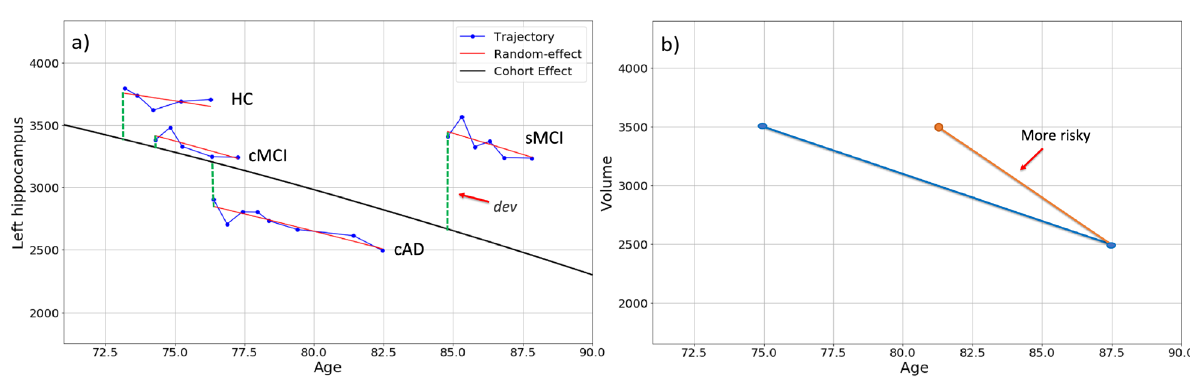
Figure 2. Box plot showing the gender specific results on RAVLT immediate recall and the ADAS13 for each of the longitudinal labels defined for the present study (Table 1).